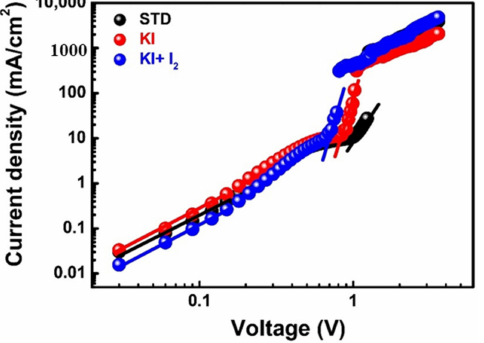
Figure 7. The SCLC measurements of perovskites films with various optimal conditions (STD, KI (30 mM), and KI (30 mM) + I 2 (3